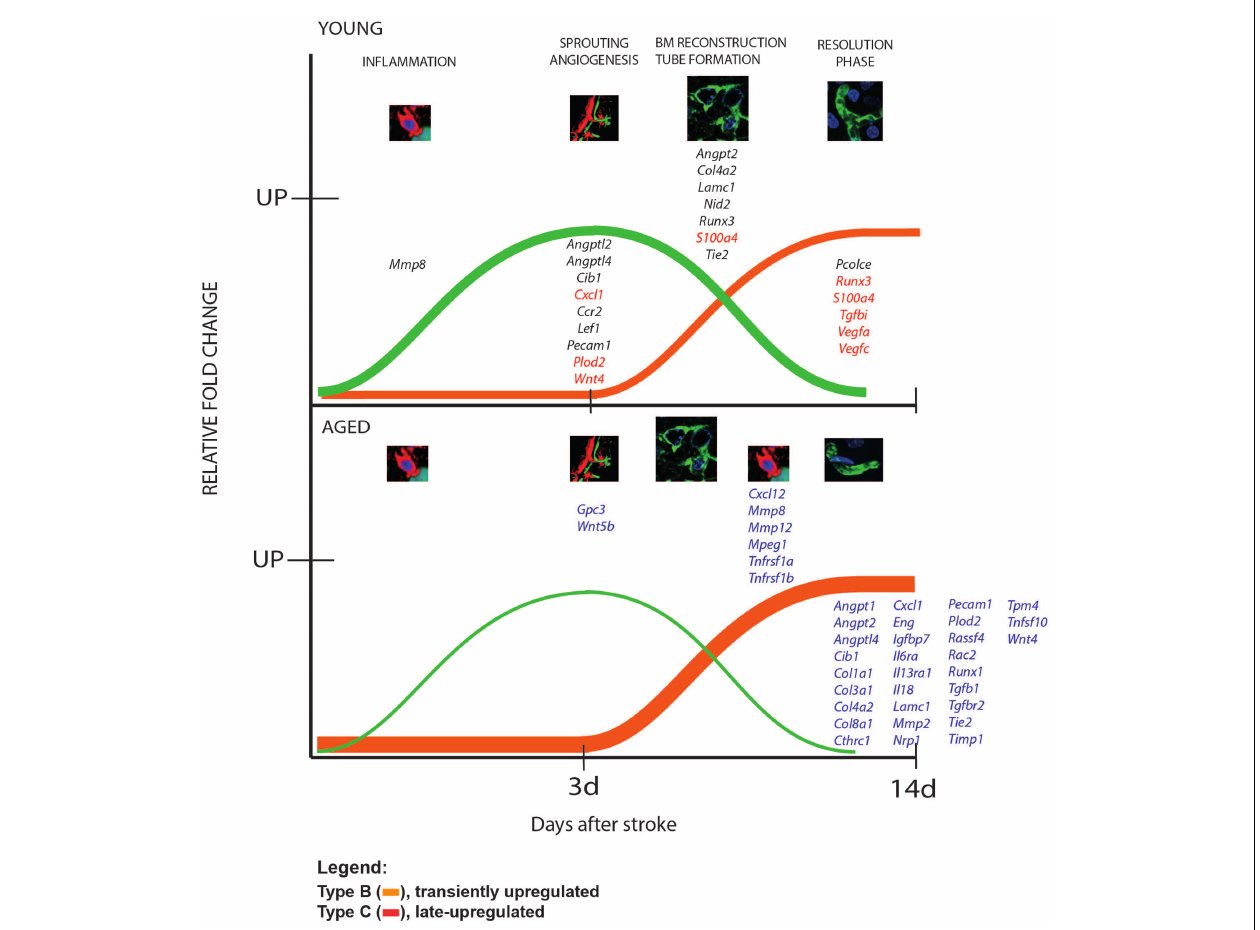
line). Please note that aged animals showed larger numbers of genes that were belatedly upregulated than the young animals.The young rats, in contrast, had a larger number of transiently upregulated including Cxcl1 , S100a4 , Runx3 , Tgfbi , Vegfa , Vegfc